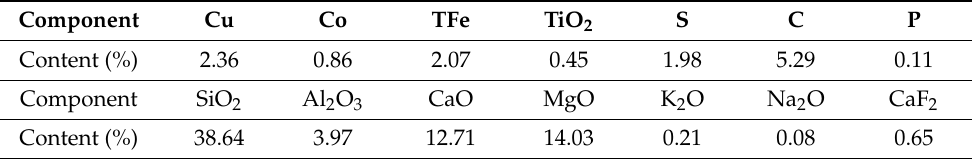
Table 2. The chemical constitution of ore.